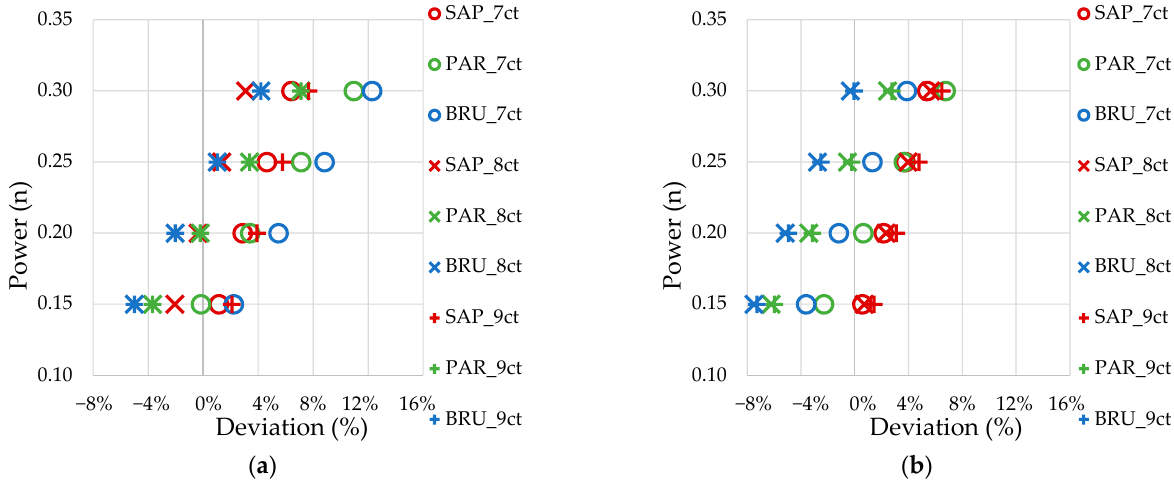
Figure 11. Effect of power and heating unit cost on the deviation ( a ) single floor model, ( b ) whole building model (cost-optimal solution based on investment and operational heating cost).